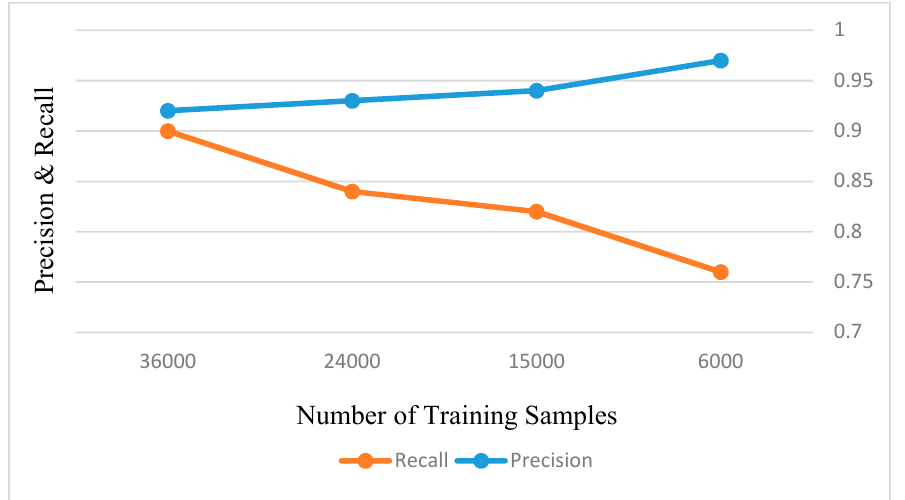
Figure 12. Number of training samples for SFCM training analysis. Table 4. SFCM ship candidate extraction performance.